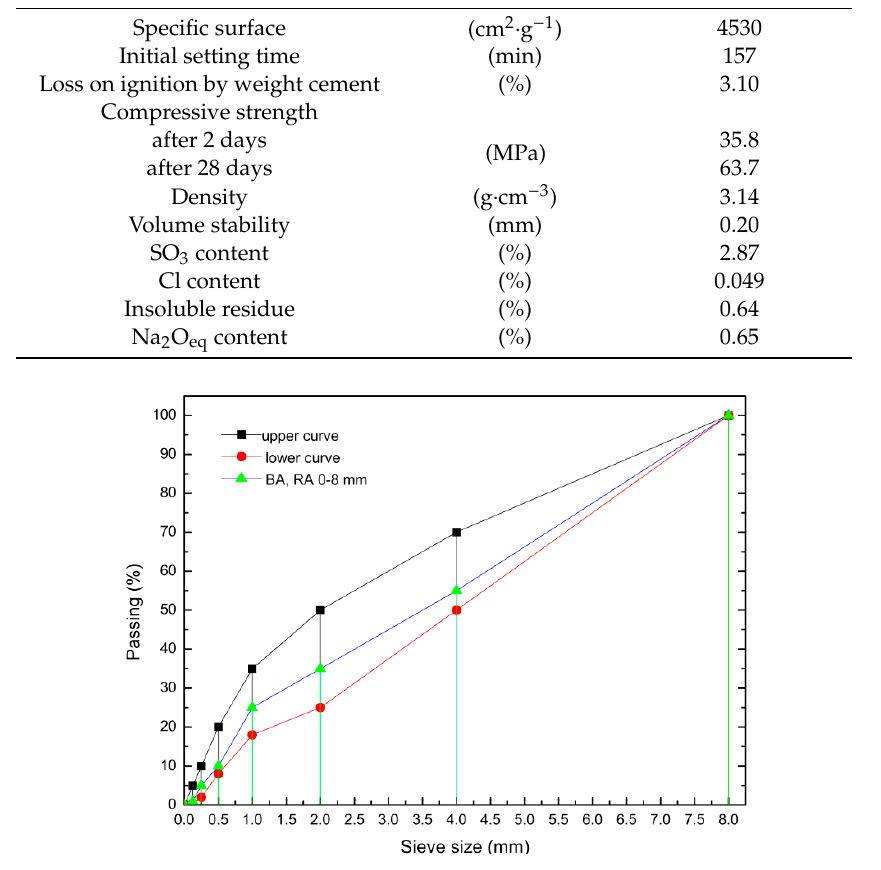
Figure 1. Gradation of basalt and recycled aggregates. Table 2. Composition of concrete mixtures.